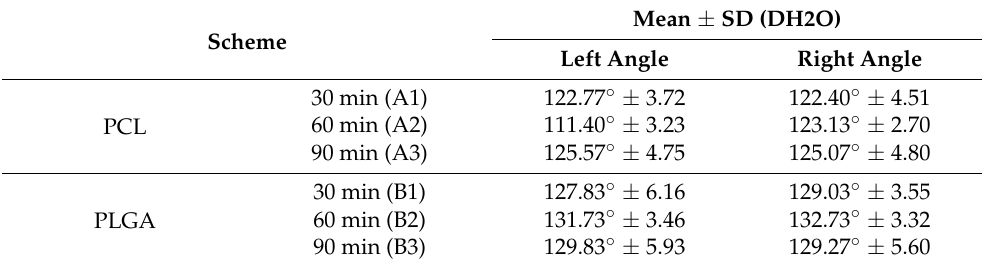
Table 2. Mean ± SEM of contact angle measurements of PCL, PLGA